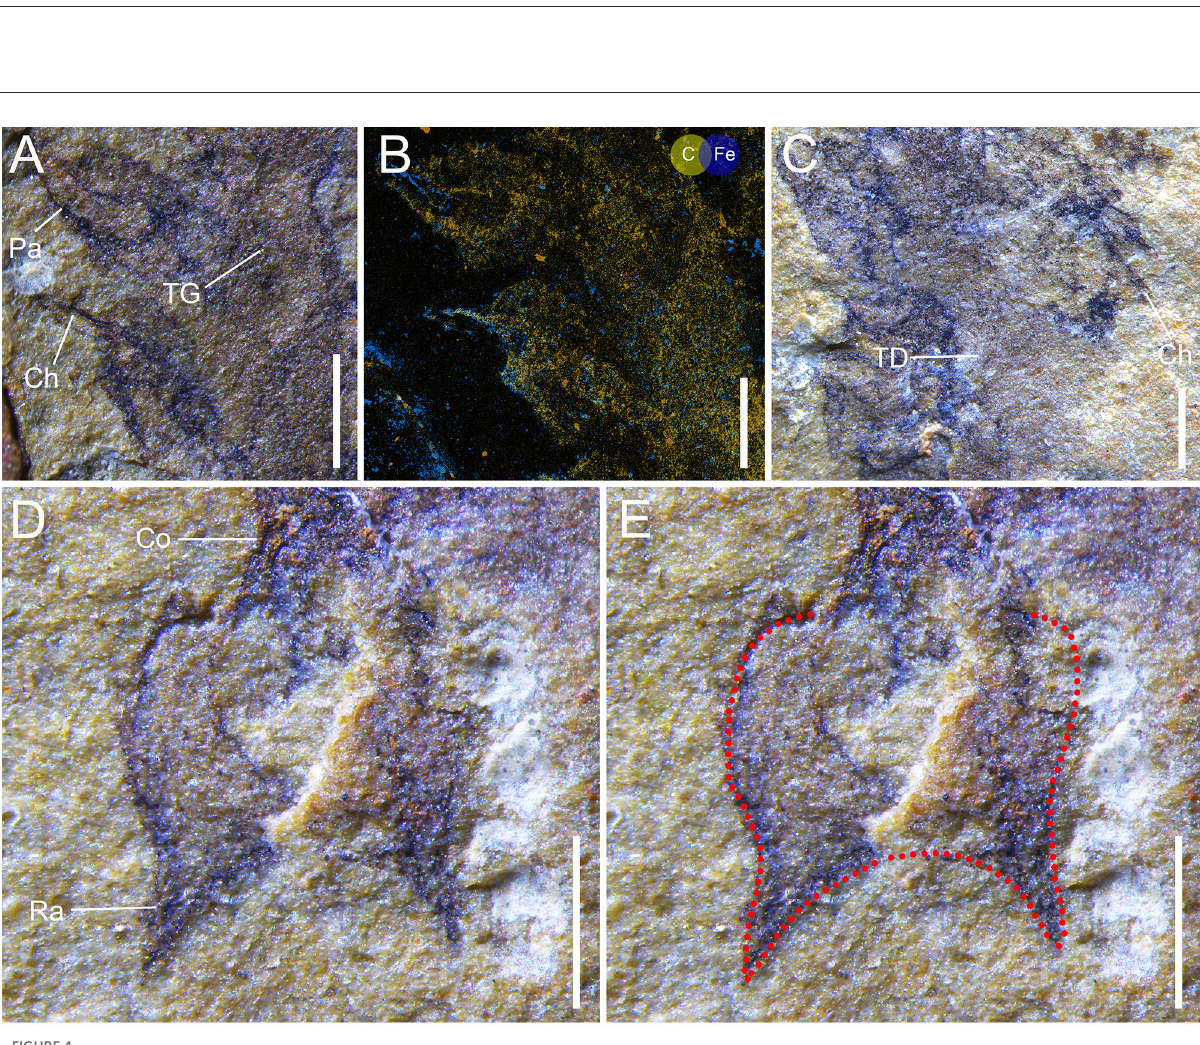
FrontiersinEcologyandEvolution